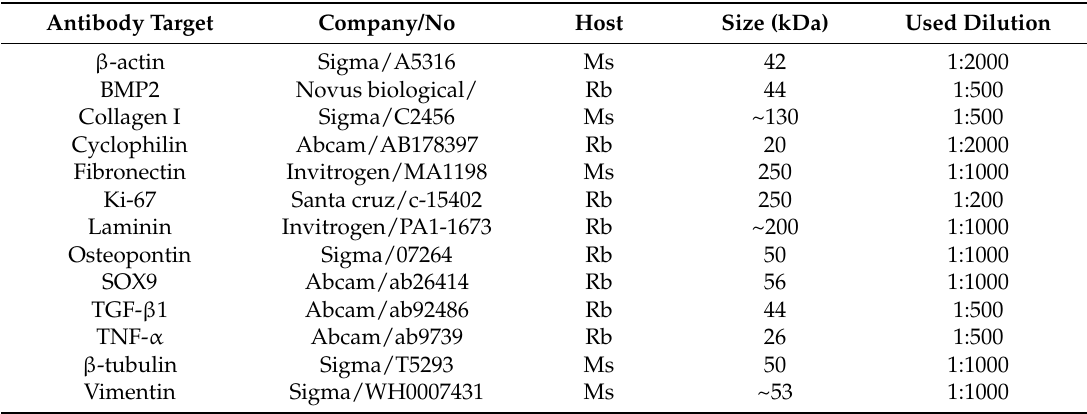
Table 3. Antibodies used for Western blot